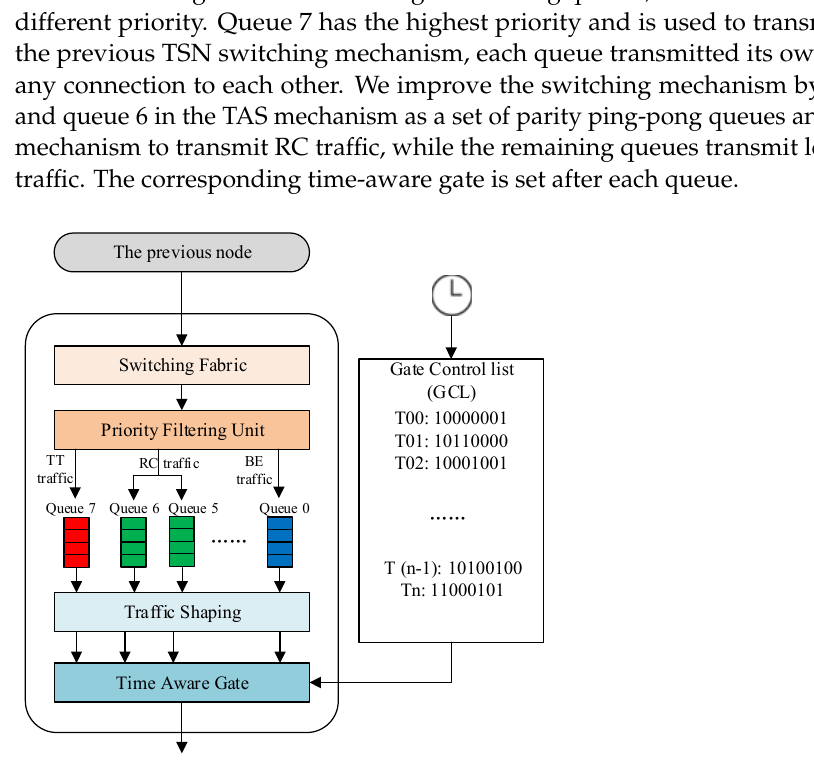
Figure 2. Hybrid traffic scheduling